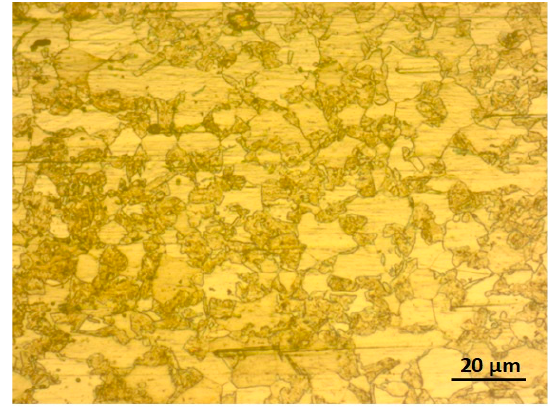
Figure 5. Optical micrograph of 430 SS.